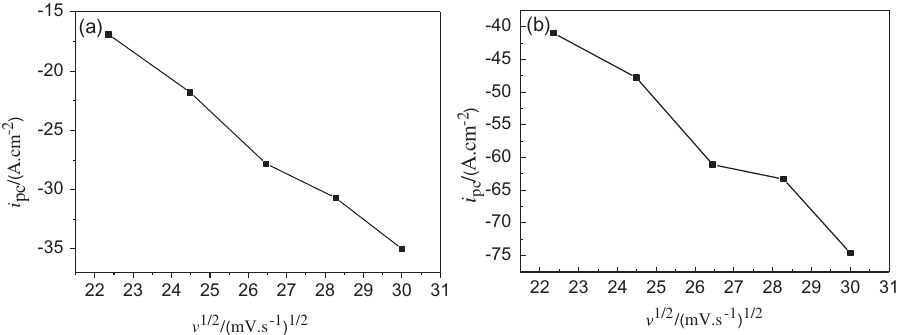
Figure 8: Cathodic peak currents at different potential scan rates on a Fe electrode in NaCl-NaF-KCl-SiO 2 (c SiO2 = 0.177 mol·L − 1 ) melt at 1,103 K. (a) I pc vs. v 1/2 , corresponding to Si(IV) → Si(II), (b) I pc vs. v 1/2 , corresponding to Si(II)